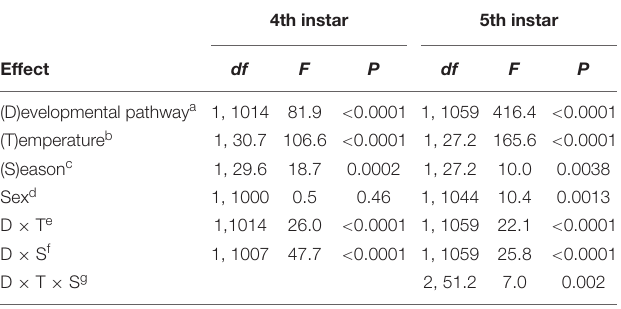
TABLE 4 | Integral growth rates (calculated as peak mass of instar 1 / 3 − mass at the beginning of the instar 1 / 3 )/(duration of the period from molt to attainment of peak body mass] in the 4th and 5th instar Araschnia levana larvae as explained by developmental pathway, temperature, season, and sex; linear mixed models (SAS, Proc MIXED, type 3 sums of squares) with brood (progeny of one female) as a random effect. 4th instar